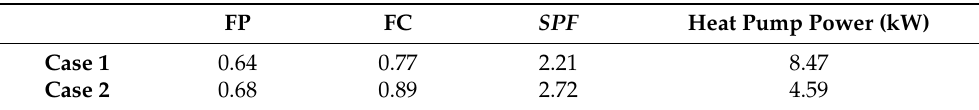
Table 5. Design parameters for the air source heat pumps in each of the locations of the building for an initial COP of 4.5.